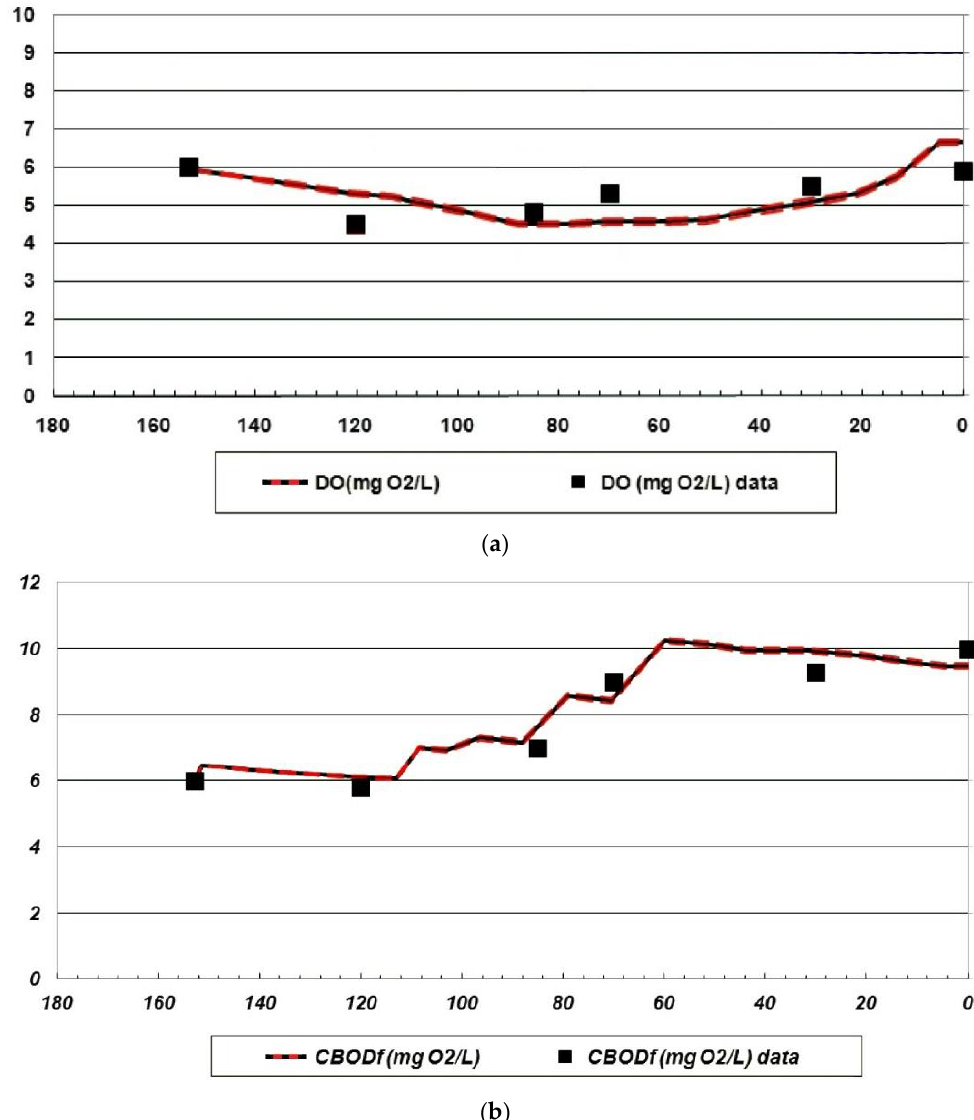
Figure 4. QUAL2K calibration results: ( a ) D.O. and ( b ) BOD. Table 2. The transfer coefficients matrix.